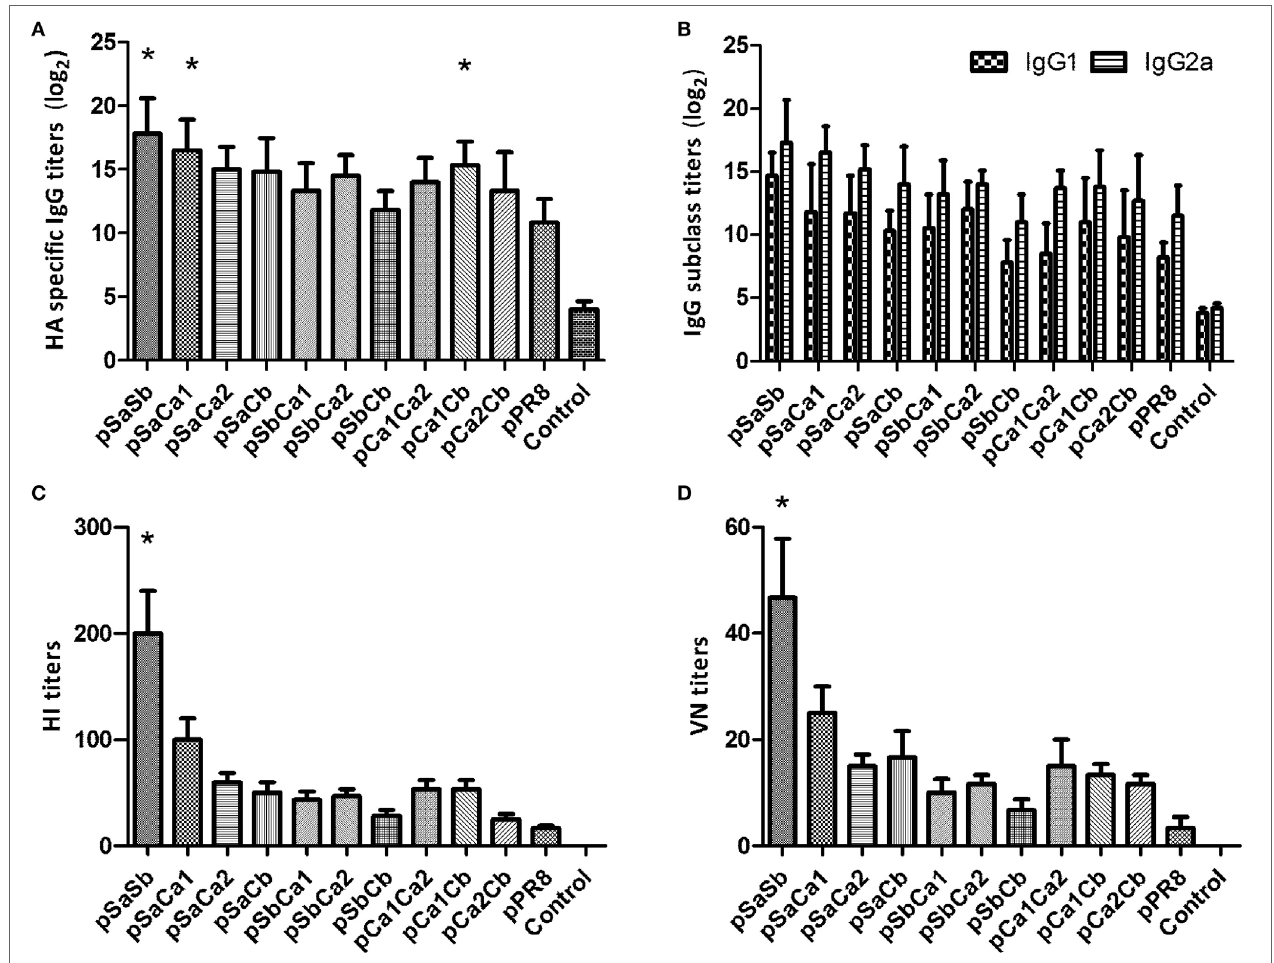
FigUre 5 | Antibody responses in mice immunized with plasmid DNAs substituted with two epitopes of the Pdm09 HA. Female BALB/c mice (6–8 weeks old) were immunized twice, at an interval of 3 weeks, with 30 µg of plasmid DNAs substituted with two epitopes of the Pdm09 HA. Thirteen days after the boost, the sera were collected for Ab analyses; (a) for immunoglobulin G (IgG); (B) for IgG subclass; (c) for hemagglutination-inhibition assay; and (D) for VN assay. Bars and whiskers represent the average and SD. Asterisk symbol (*) indicates a significant difference compared with pPR8 ( p <